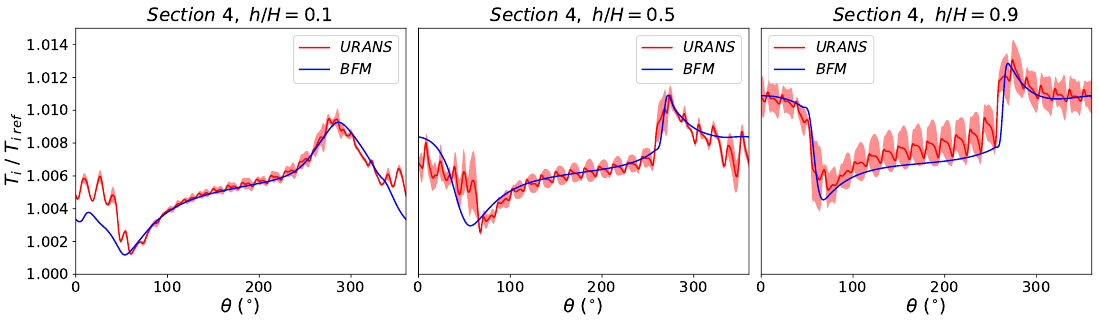
Figure 19. Azimuthal distribution of absolute total temperature in Section